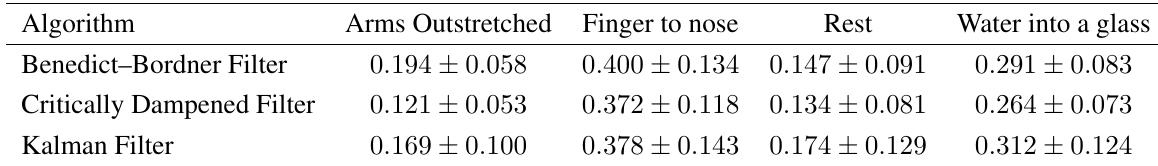
Table 2 . Kinematic Tracking Error (rad/s) for voluntary movement tracking algorithms organized by task. Table provides mean (cid:6) standard deviation.